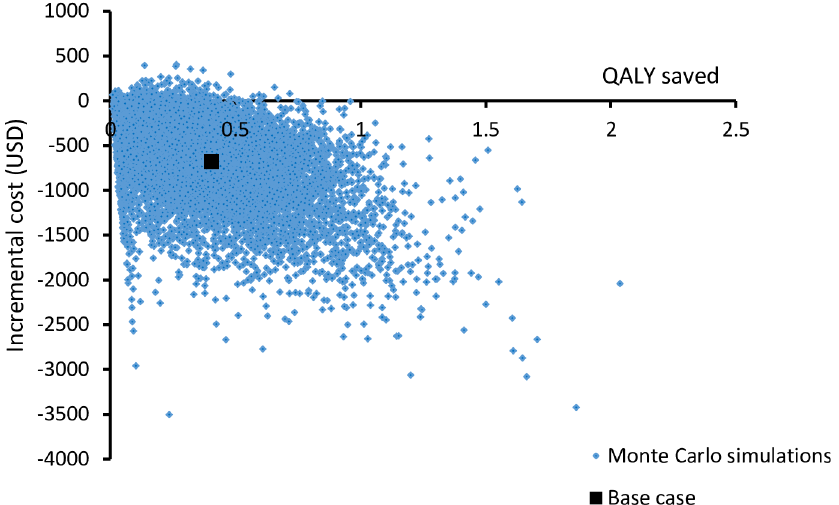
Fig 4. Scatter plot of incremental cost against incremental QALYs of ribotype-guided FMT versus vancomycin treatment.